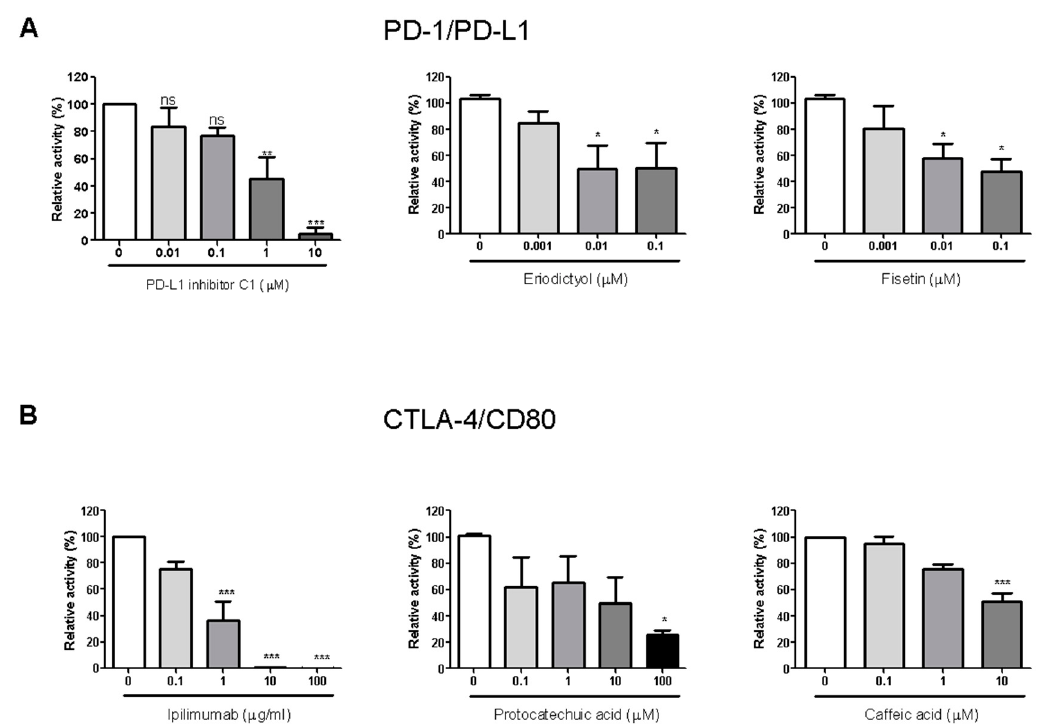
Figure 3. Immune checkpoint blocking effects of isolated compounds by competitive Enzyme-Linked Immunosorbent Assay (ELISA). Effect of PD-L1 inhibitor C1, compounds eriodictyol ( 7 ) and fisetin on PD-1/PD-L1 binding activity ( 9 ) ( A ); effect of anti-CTLA-4 antibody (Ipilimumab), compounds protocatechuic acid ( 2 ) and caffeic acid ( 19 ) on CTLA-4/CD80 binding activity ( B ). The relative binding activity was normalized to the relative percentage of the vehicle control group. Half-maximal inhibitory concentration (IC 50 ) was calculated using Prism “log[inhibitor] vs. normalized response” equation. All results are presented as the mean of three independent biological replicates. * p < 0.05, ** p < 0.01, *** p < 0.001, compared with the vehicle control group.